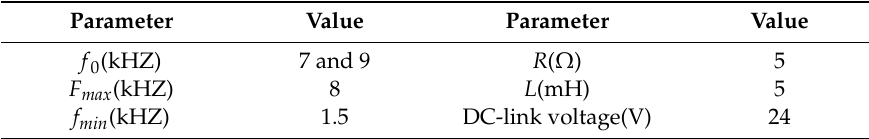
Table 1. System parameters.